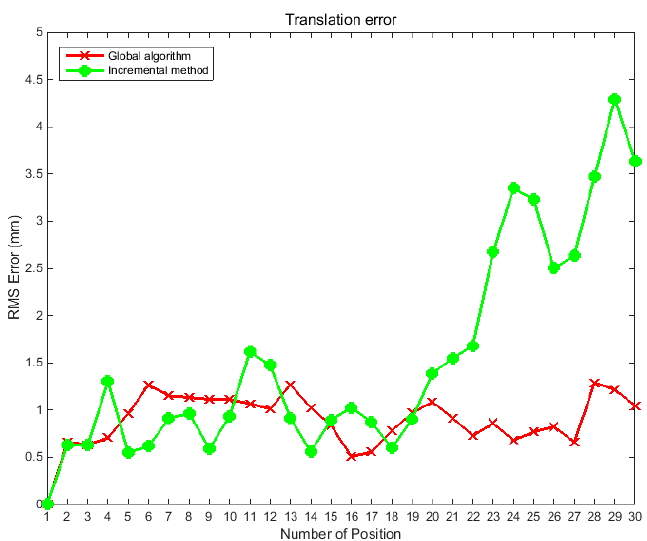
Figure 6. RMS error curves of translation at different positions before and after global optimization.